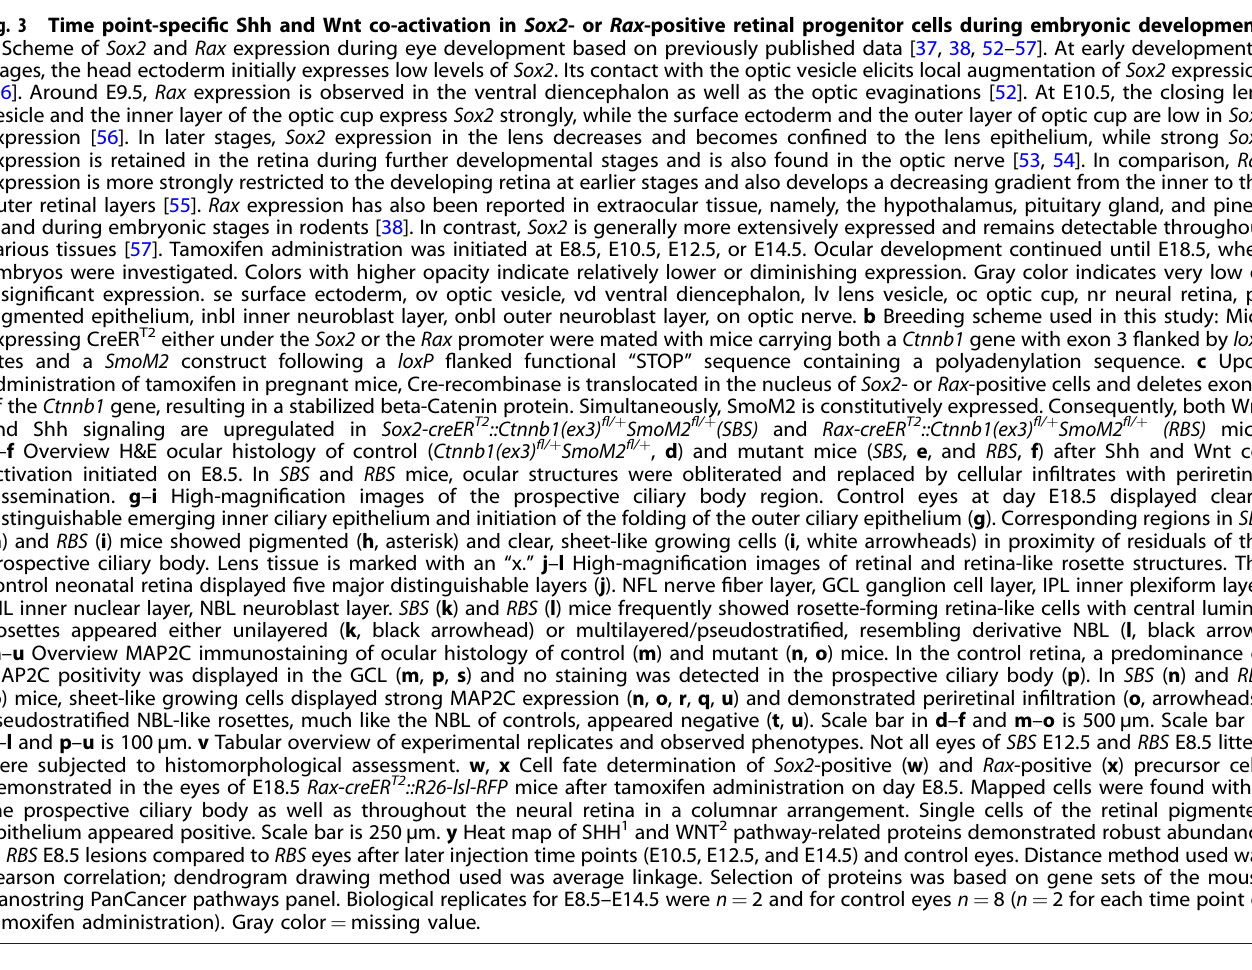
Fig. 3 Time point-speci fi c Shh and Wnt co-activation in Sox2 - or Rax -positive retinal progenitor cells during embryonic development. a Scheme of Sox2 and Rax expression during eye development based on previously published data [37, 38, 52 – 57]. At early